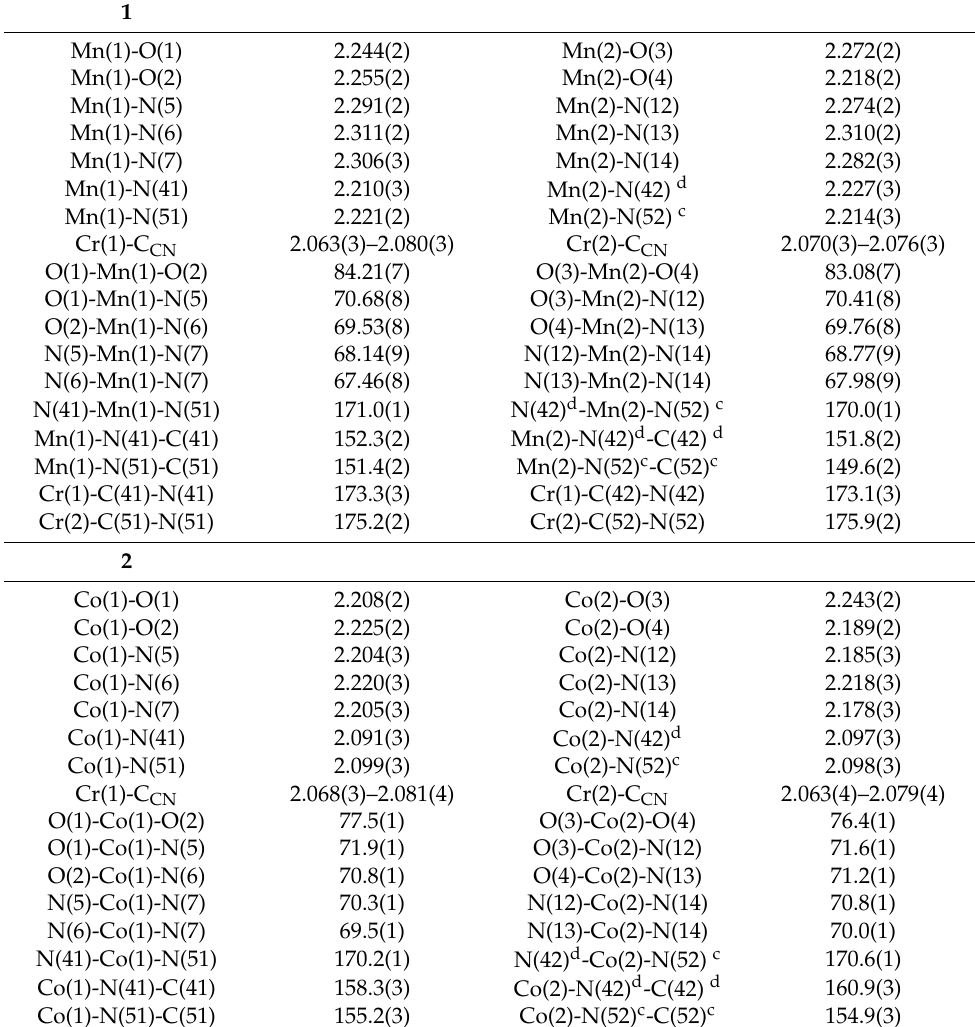
Table A1. Selected bond lengths (Å) and angles ( ◦ ) in 1 – 4